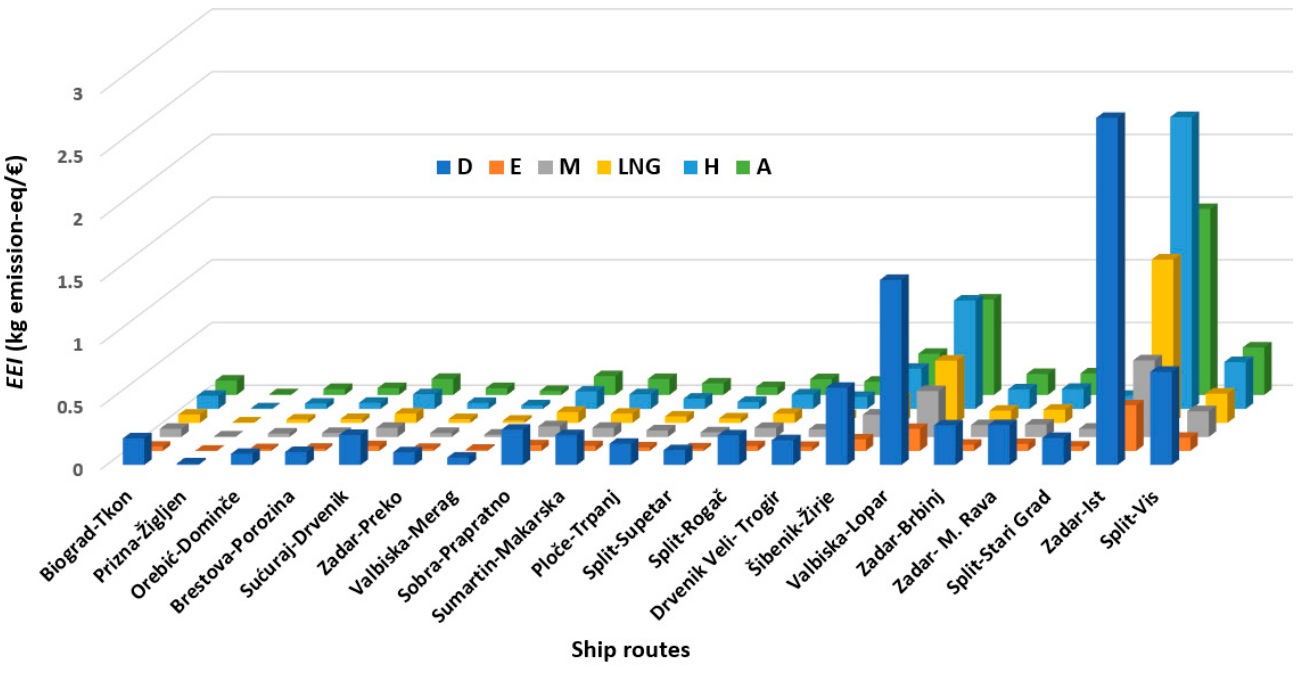
Figure 5. Calculated EEI for ships with different power